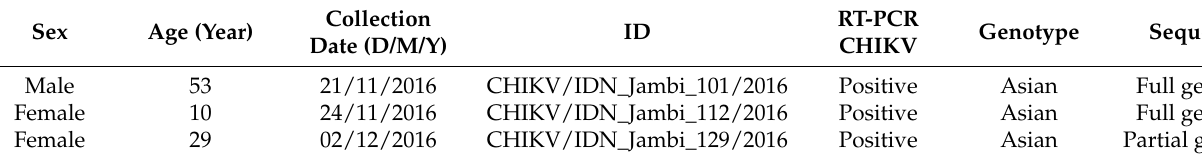
Table 3. List of samples tested positive for CHIKV from Jambi.